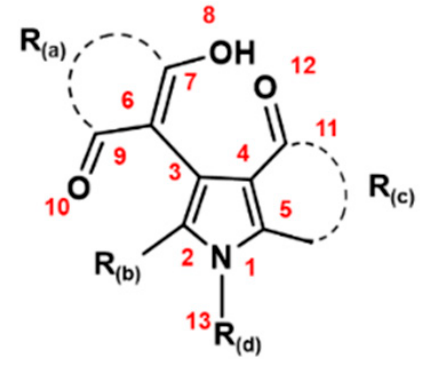
Figure 5. The main skeleton of pyrrole derivatives.